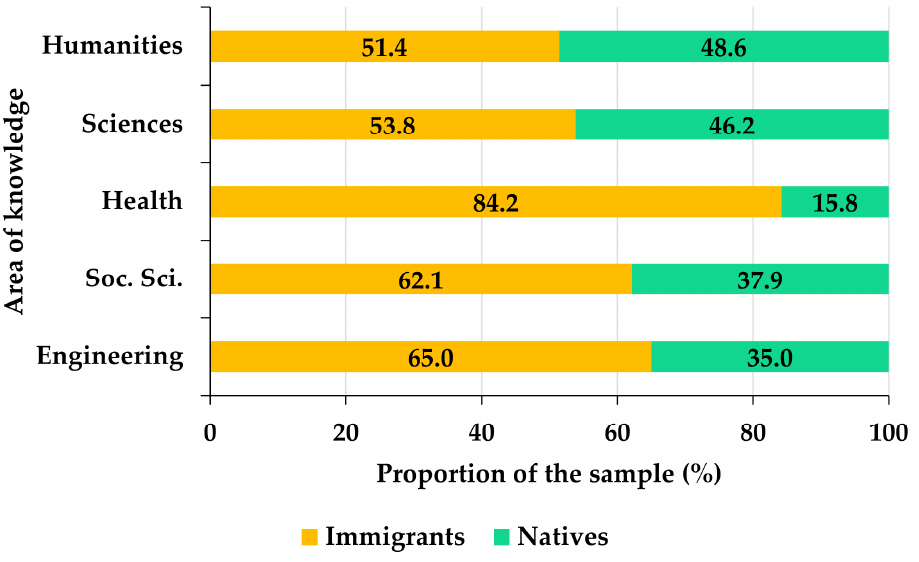
Figure 3. Distribution of the participants by knowledge area and digital generation.